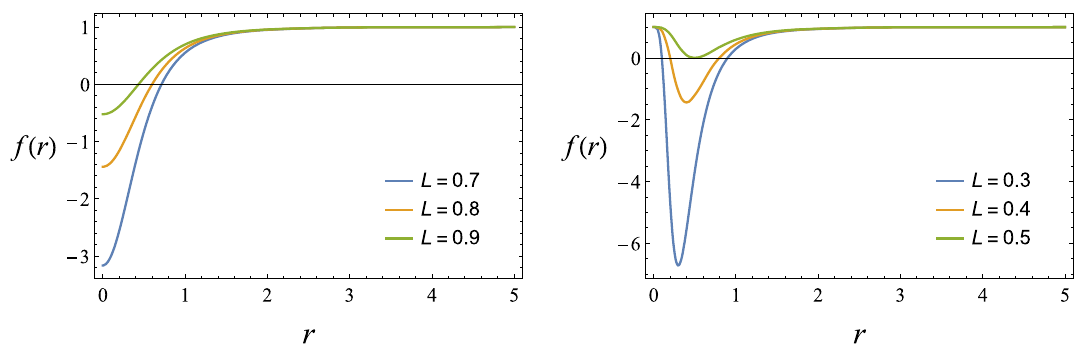
Fig. 1 f ( r ) with respect to r for the cases of N = 1 / 2 (left) and N = 1 (right), only one horizon in the former case but normally two horizons in the latter. Note that the values of L satisfy L 2 < 1 in the left graph and L 2 ≤ 1 / 4 in the right graph, respectively